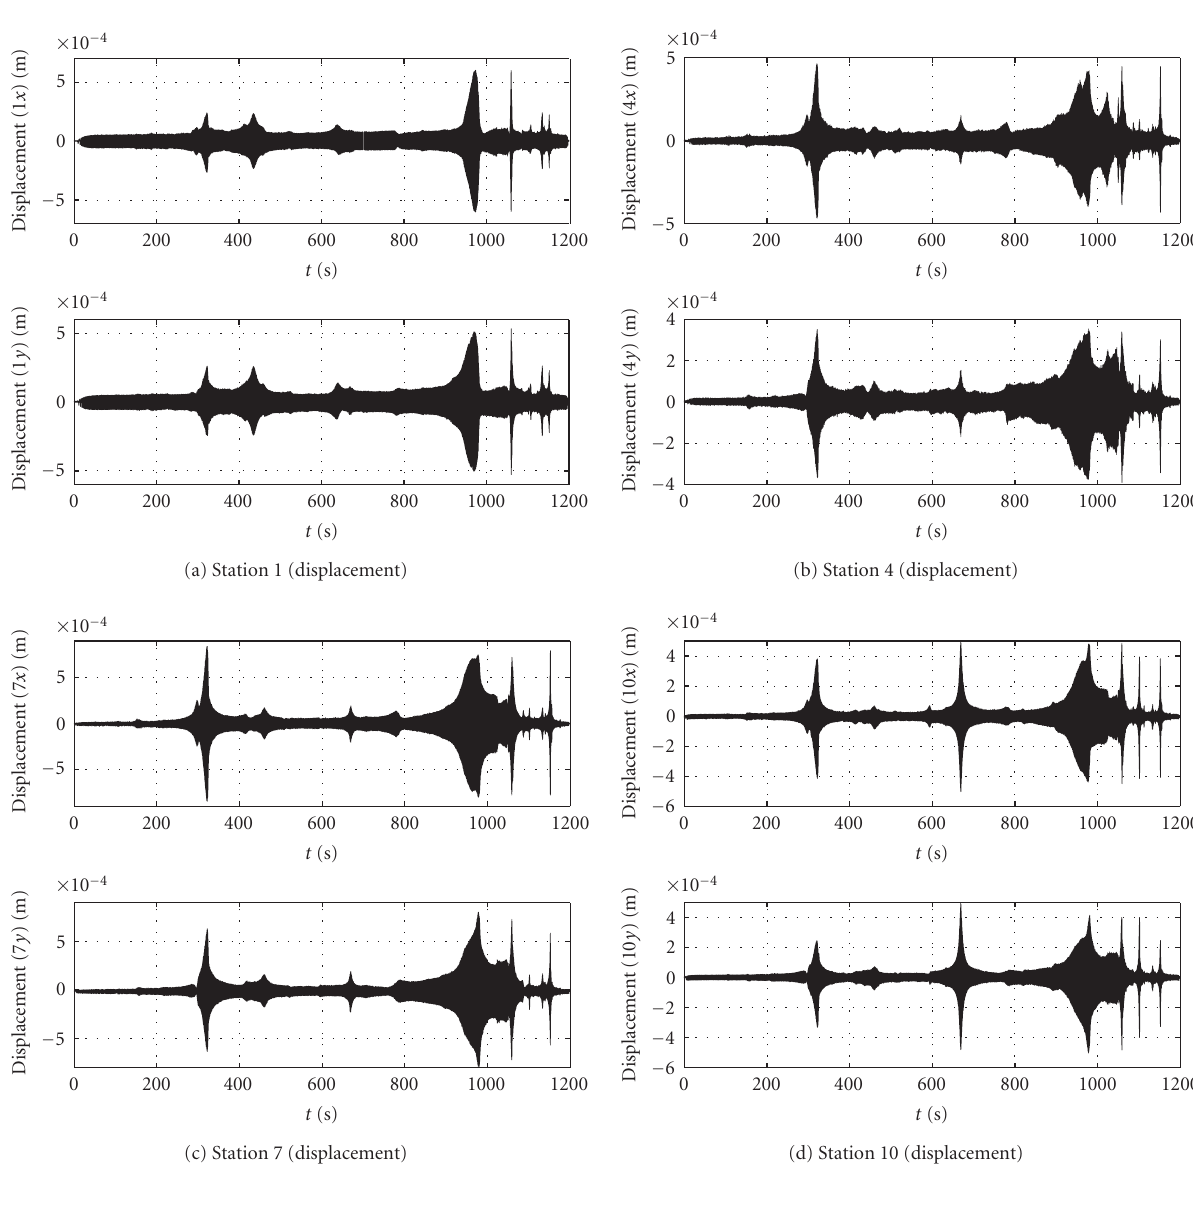
Figure 10: Time history measurements (stations 1, 4, 7, and